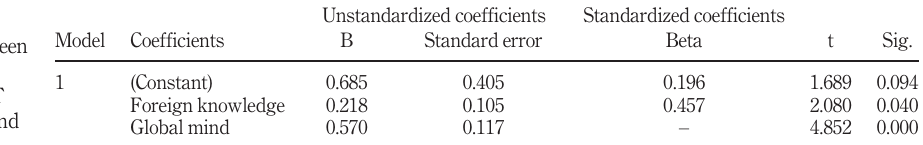
Table 2. Regression